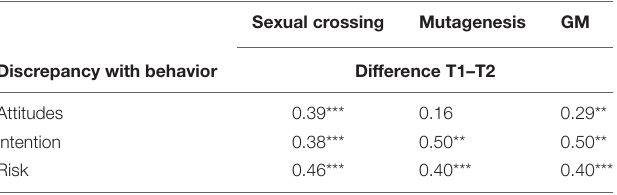
TABLE 2 | Means, standard deviations, and partial correlations, controlling for liking of the respective food item (i.e., Tomatoes, Rice, and Canola oil), between the discrepancy scores and difference scores.